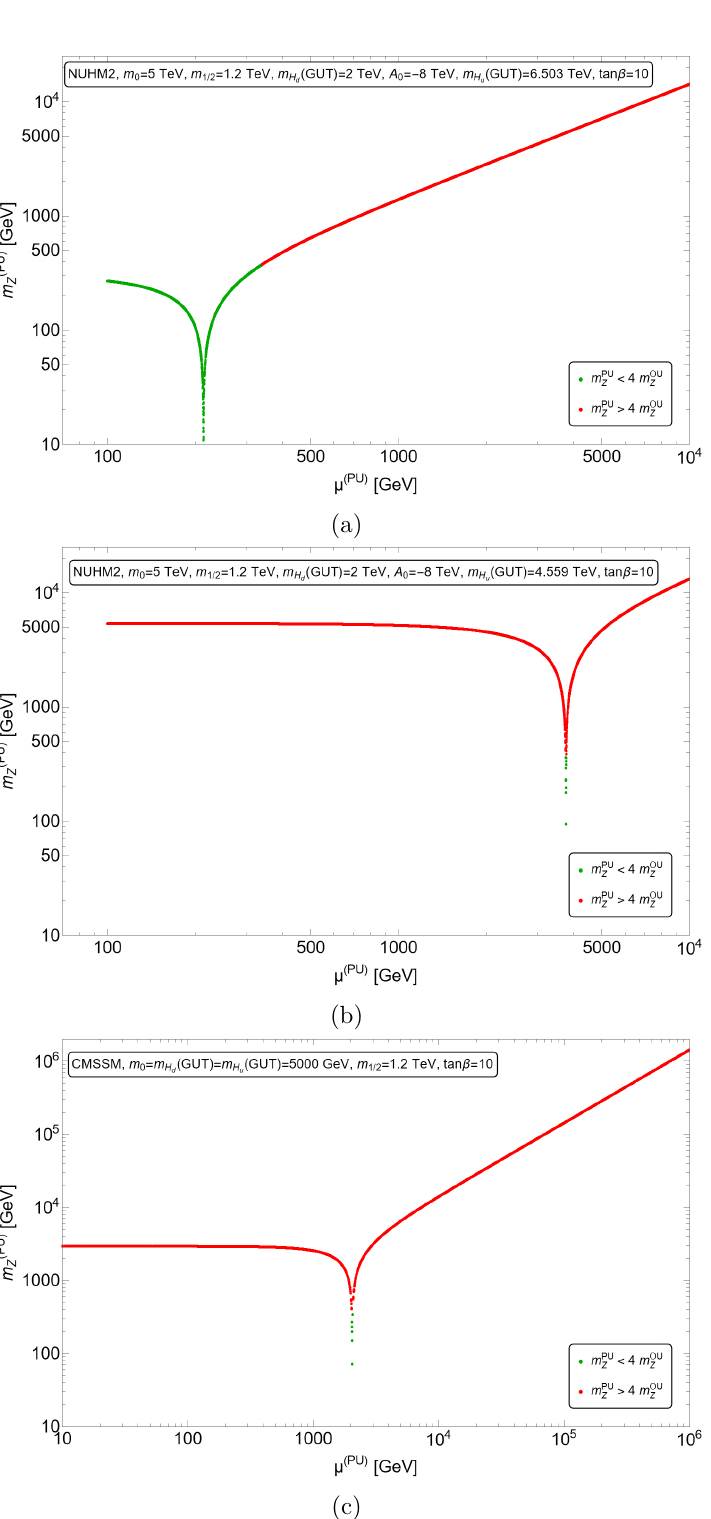
> 4 m OU weak weak